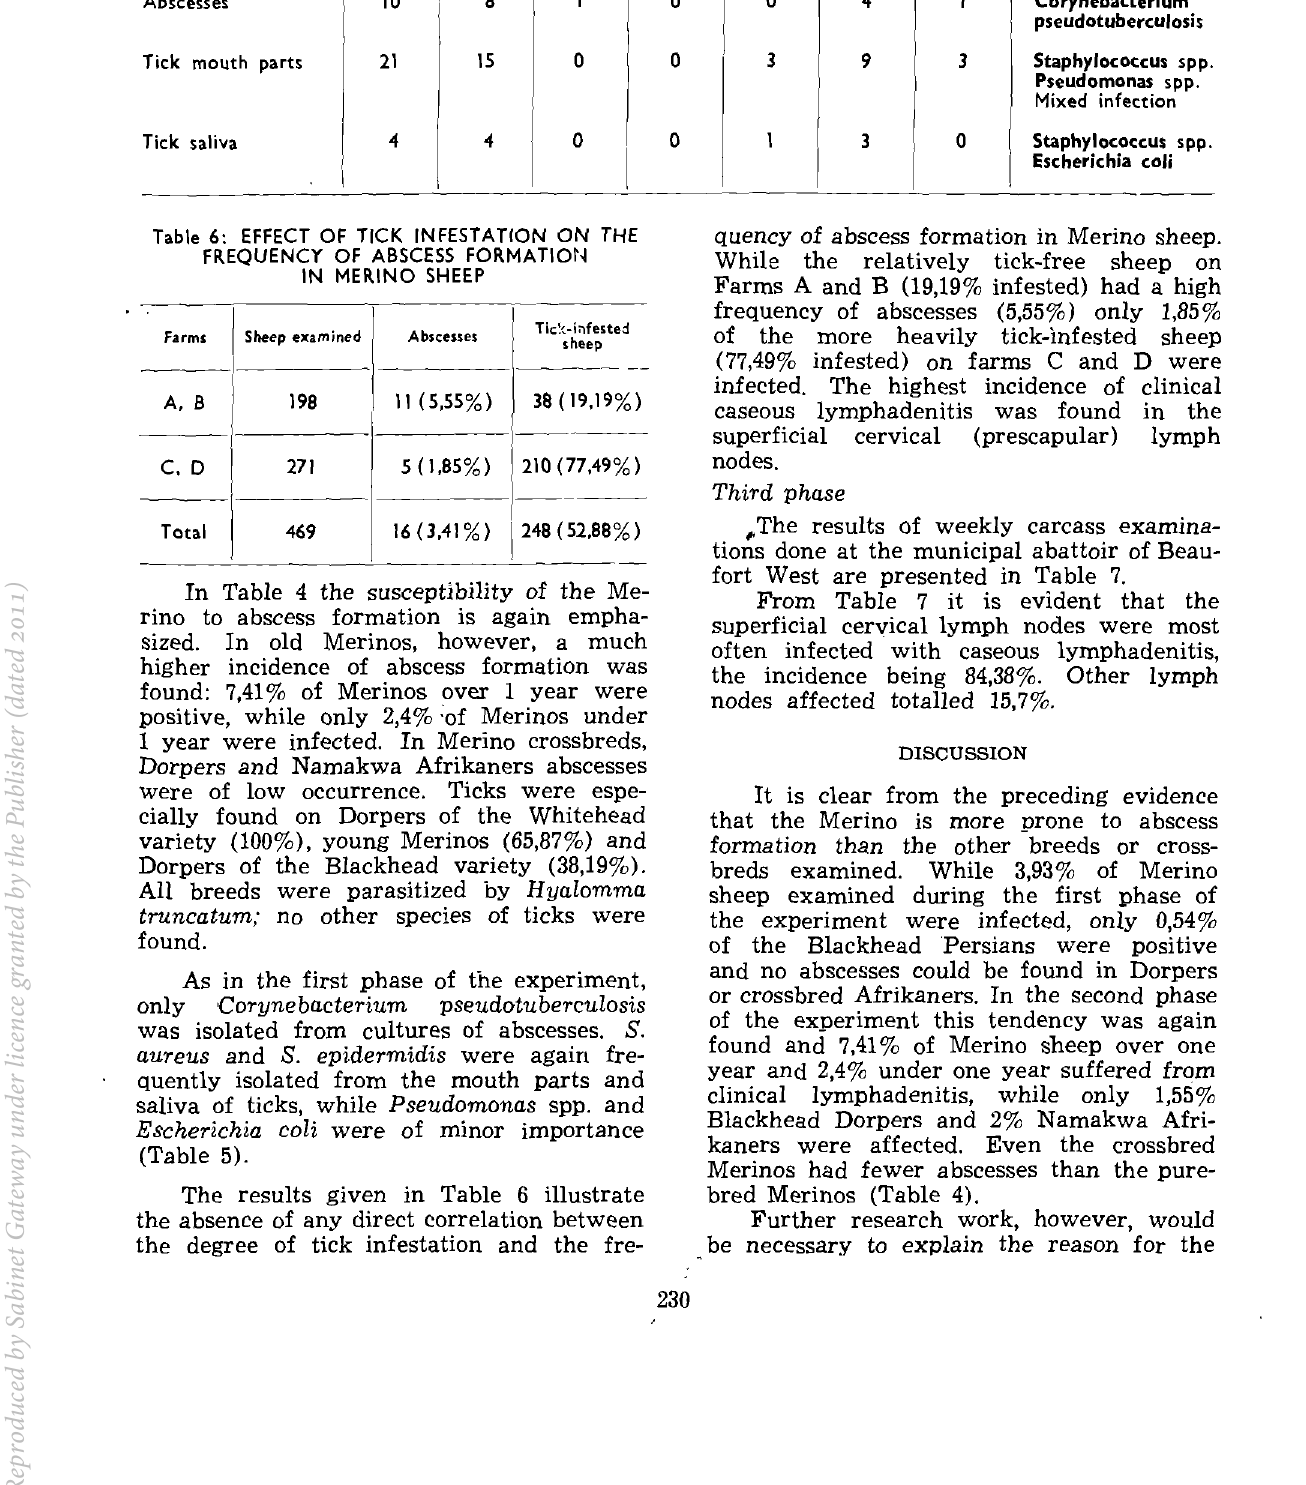
Table 6: EFFECT OF TICK INFESTA nON ON THE FREQUENCY OF ABSCESS FORMATION IN MERINO SHEEP